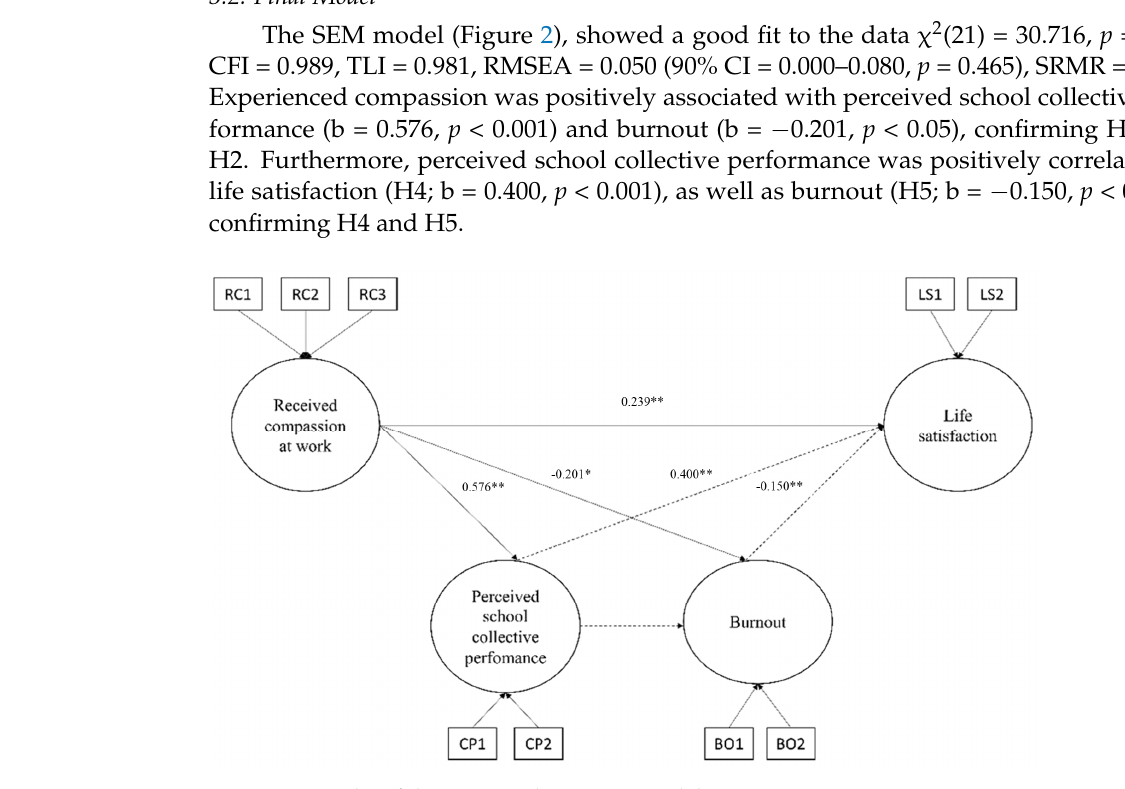
Figure 2. Results of the structural equation model. * = p <0.05, ** = p <0.01 The direct association between experienced compassion and life satisfaction (H3) was confirmed. (b DIRECT =0.239, p = 0.007). At the same time, while perceived school collective performance partially mediated the relationship between experienced compassion and life satisfaction (b INDIRECT = 0.230, p = 0.000), burnout did not mediate such an association (b INDIRECT = ns). Thus, H6 was only partially